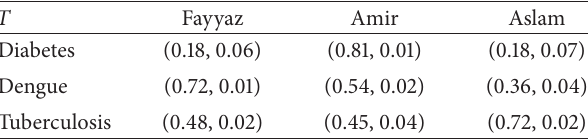
Table 5: Intuitionistic fuzzy relation 𝑅(𝑆 → 𝑃) . Table 6: Composition 𝑇 = 𝑅 ∘ 𝑄(𝐷 → 𝑃)